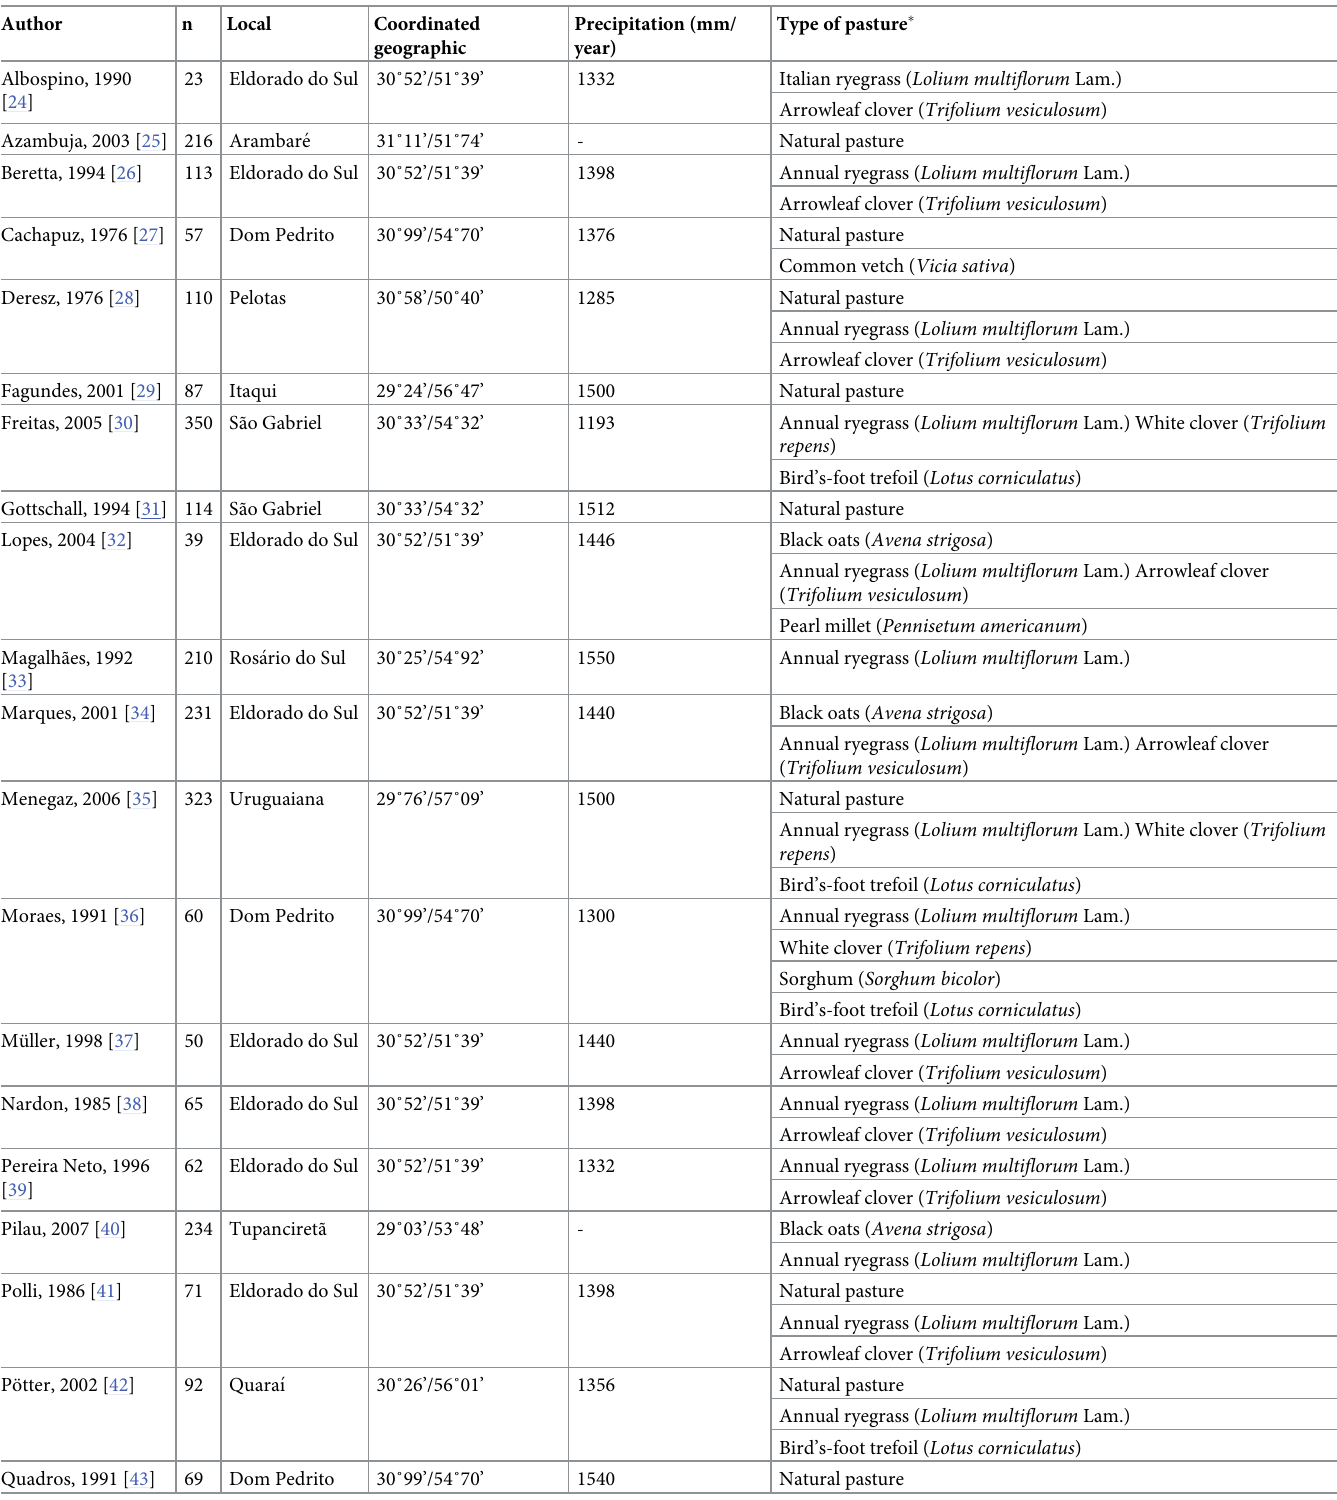
Table 1. Relation of studies of database with n (number of animals), location, coordinated geographic, precipitation and type of pasture in southern